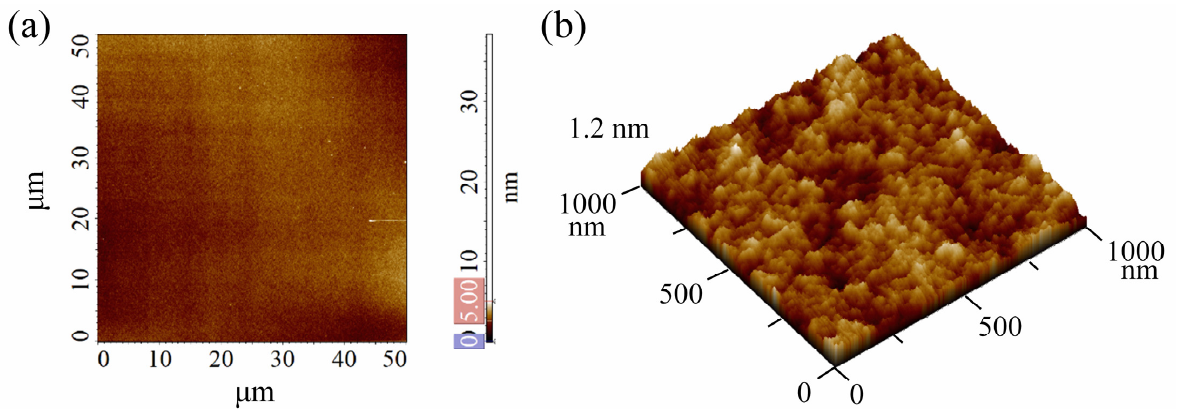
Figure 2. AFM high-resolution images of PMMA surface, acquired on ( a ) (50 × 50) µ m and ( b ) (1 × 1) µ m areas. The pink and blue boxes on the z-scalebar in ( a ) represent the minimum and maximum adjustment of the colour scale.